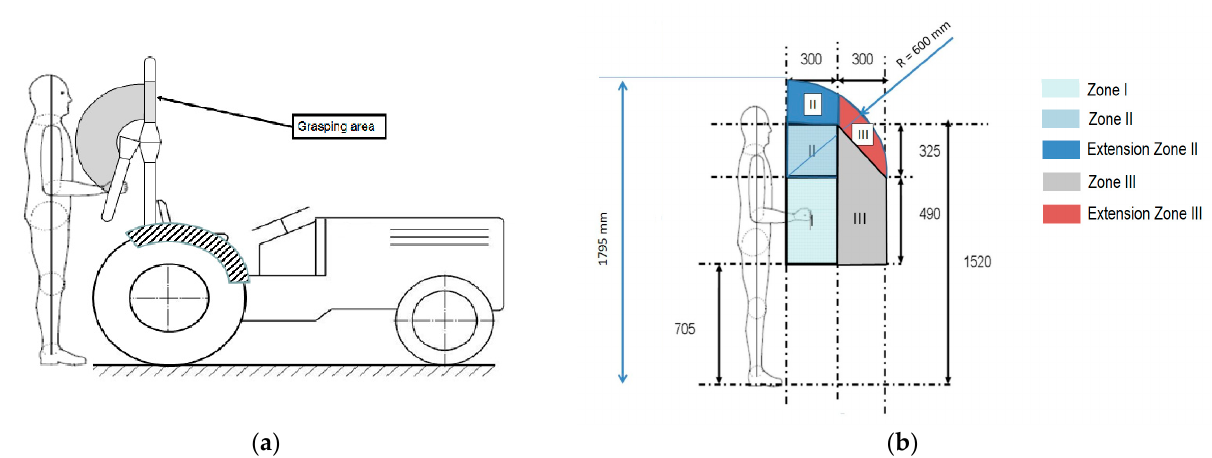
Figure 2. OECD requirements to guarantee a safe and comfortable FROPS operation: ( a ) accessible zones to handle the roll-bar in front of its trajectory (OECD Standard Code 7), and ( b ) grasping areas (OECD Standard Code 7). Reprinted with permission from [14].